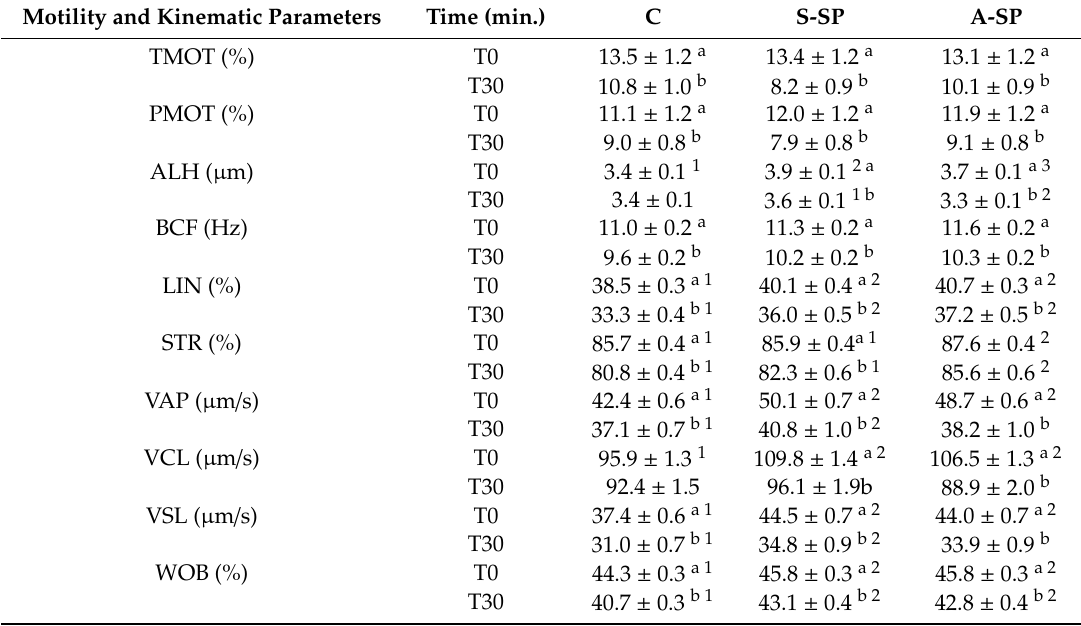
Table 1. Total motility (TMOT), progressive motility (PMOT), and kinematic parameters of spermatozoa after thawing (T0) and after 30 min incubation at 37 ◦ C (T30) with the addition of seminal plasma. Motility and Kinematic Parameters Time